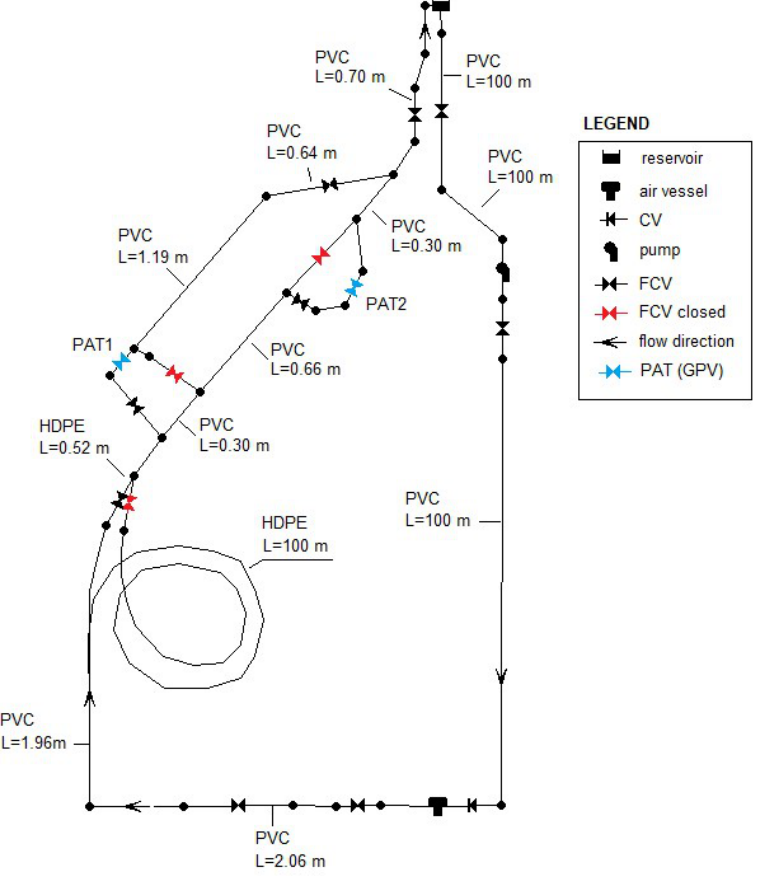
Figure 7. Schematic of the experimental set-up in EPANET. CV: check valve; FCV: flow control valves; GPV: general purpose valves.